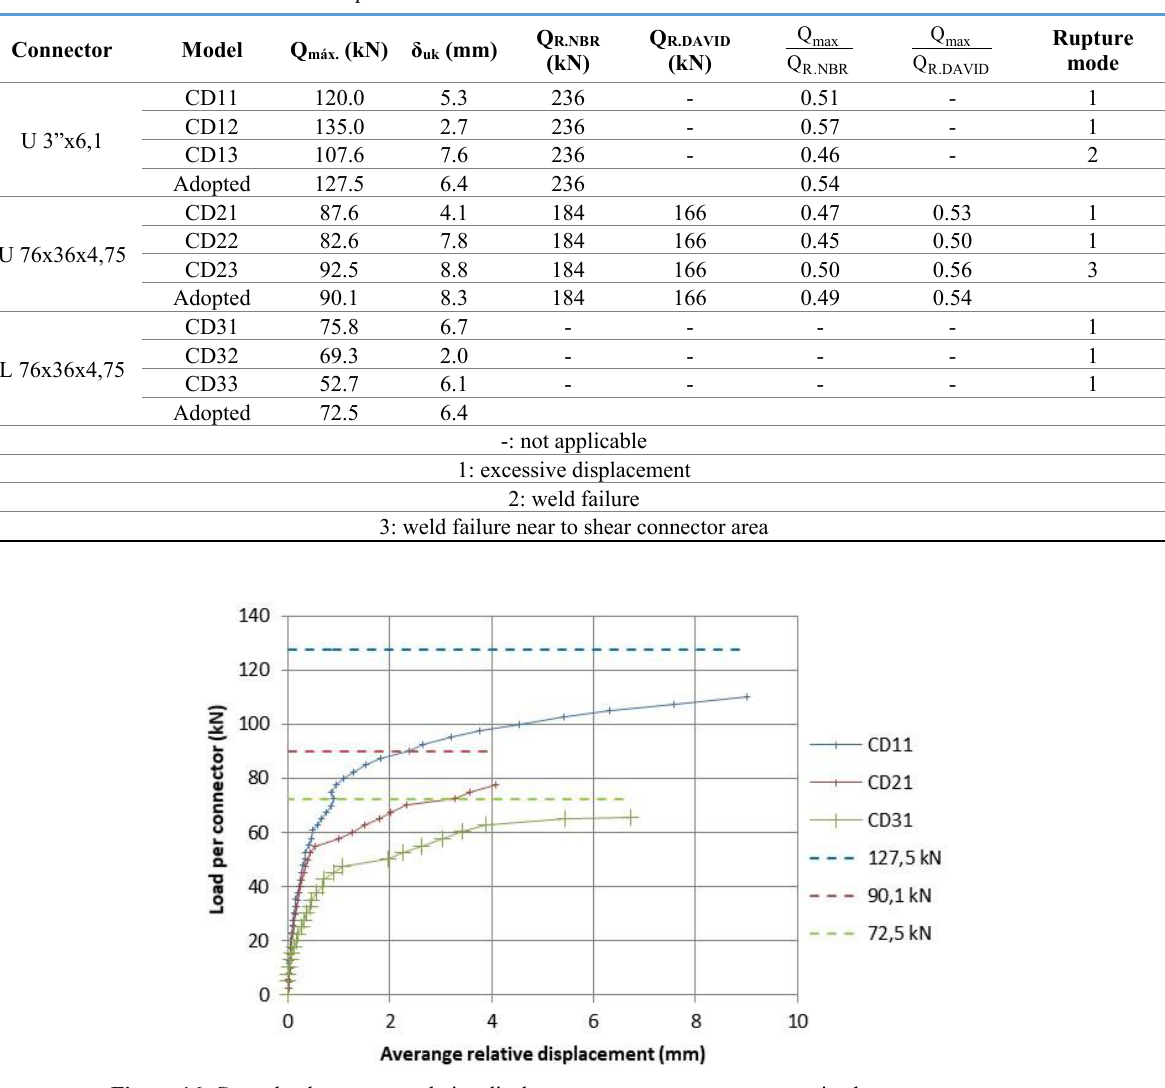
Figure 16. Curve load x average relative displacement per connector comparative between connectors.